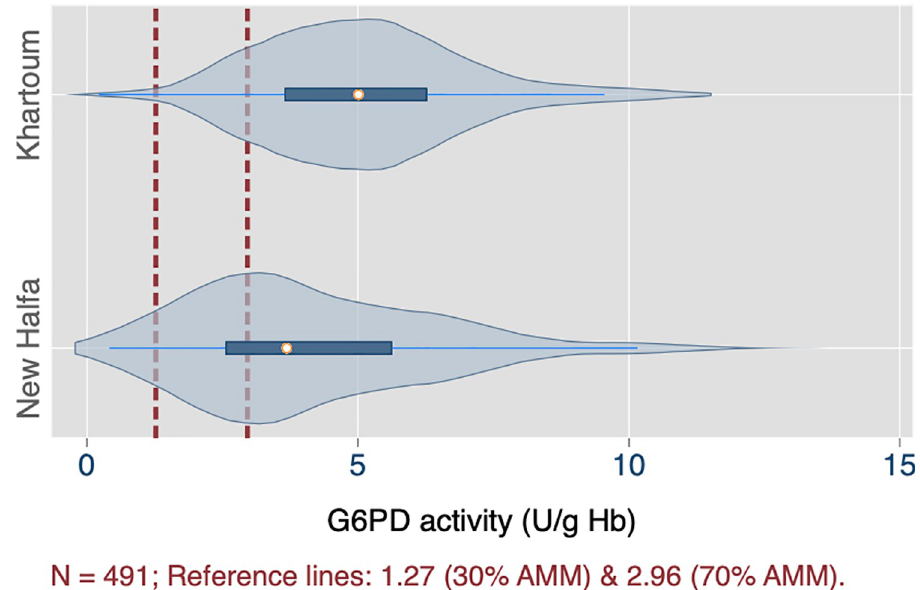
Fig 2. Distribution of G6PD activities in study population, by gender (n = 491).